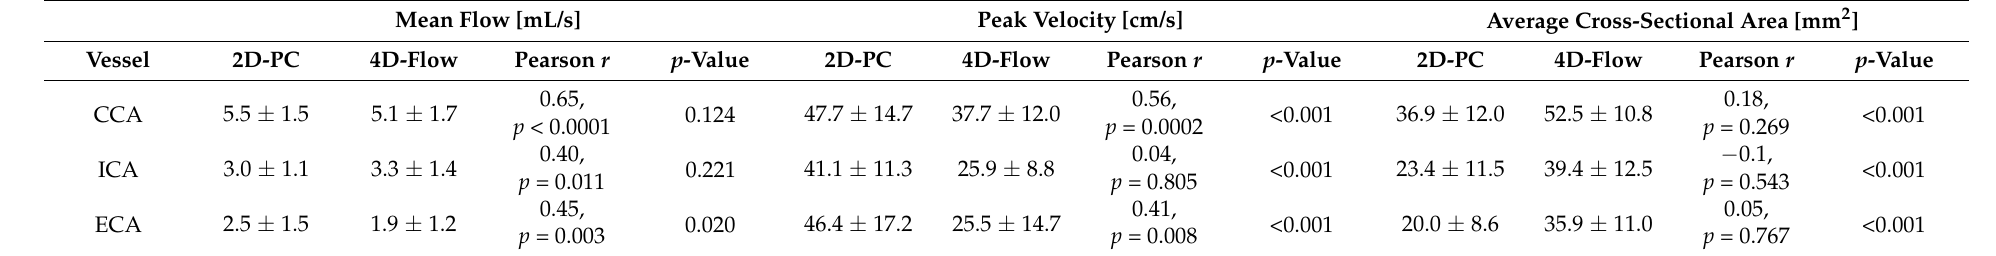
Table 1. Patients’ mean flow, peak velocity, and average cross-sectional